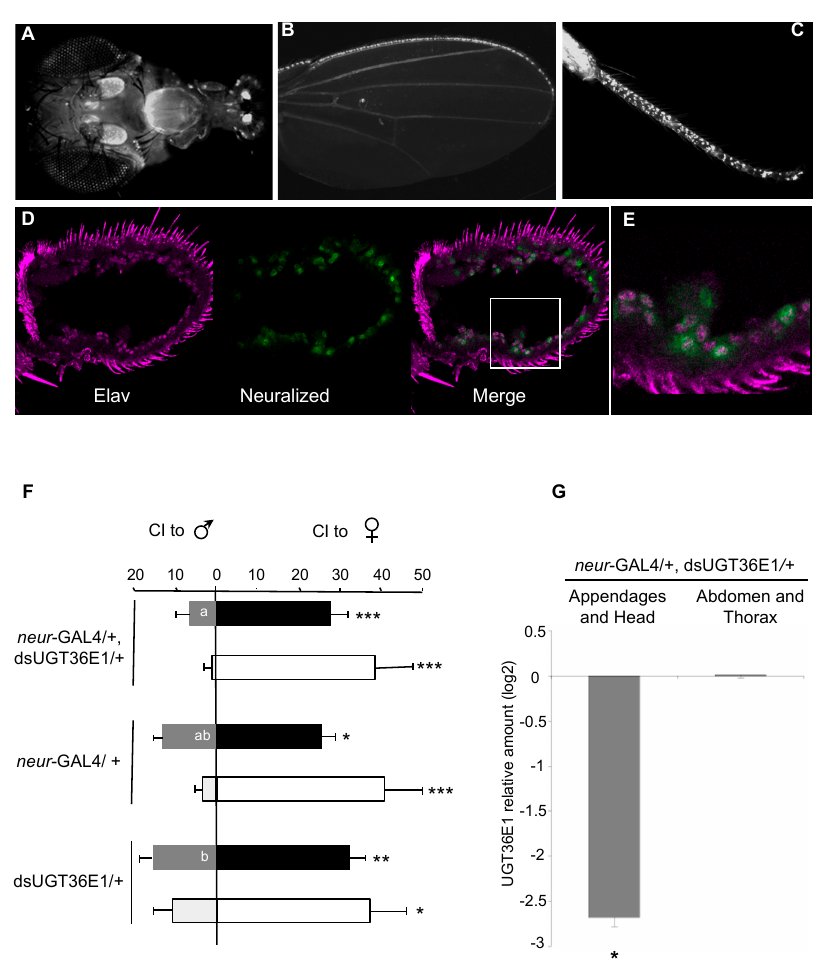
Figure 2. E ff ect of dsUGT36E1 in the peripheral chemosensory system. A strong expression of neuralized -GAL4 ( neur- GAL4) was detected in ( A ) the antennae and the proboscis, ( B ) wing margins, ( C ) legs of adult flies. ( D ) Antenna stained for Elav protein (red) and anti-GFP ( neur -GAL4). ( E ) Magnified view of antennal neurons expressing Elav and neur -GAL4. ( F ) Male ability to discriminate sex partners in “ neur- GAL4 /+ , dsUGT36E1 /+ ” testers and in both transgenic controls ( neur- GAL4 /+ and dsUGT36E1 /+ ) under red light (filled bars) and white light (empty bars). For each test, n > 35. ( G ) Real-time PCR analysis showing UGT36E1 mRNA level in di ff erent tissues of “ neur- GAL4 /+ , dsUGT36E1 /+ ” flies. The significant di ff erence in transcript level ratio is based on a comparison between control (dsUGT36E1 /+ ) and “ neur- GAL4 /+ , dsUGT36E1 /+ ” genotypes (pair-wise fixed reallocation randomization test). For statistics and conditions, see Figure 1. *** p < 0.001; ** p < 0.01; * p < 0.05.